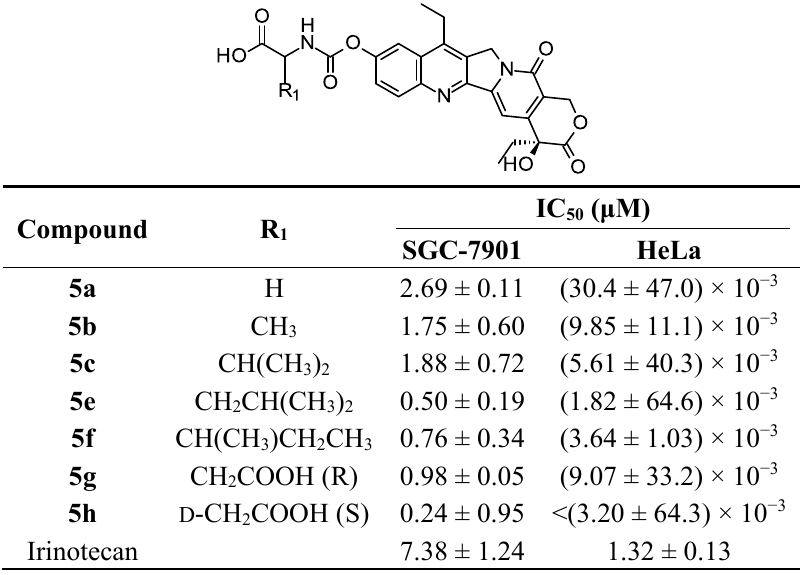
Table 1. Antiproliferative activities of the derivatives against human cancer cell